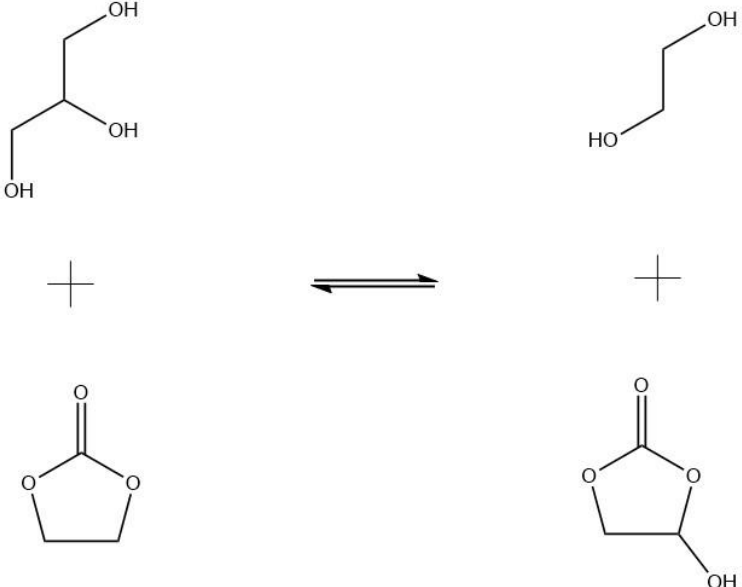
Figure 1. Glycerol transesterification or transcarbonation with ethylene carbonate to render glycerol carbonate and monoethylene glycol (MEG). carbonate and monoethylene glycol